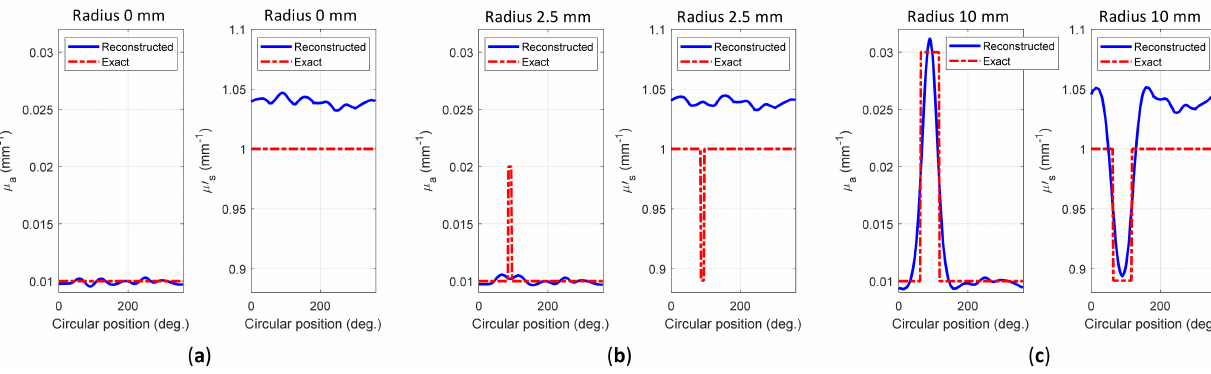
Figure 12. Circular profile of case A2 for ( a ) homogeneous, ( b ) invisible inclusion, and ( c ) visible